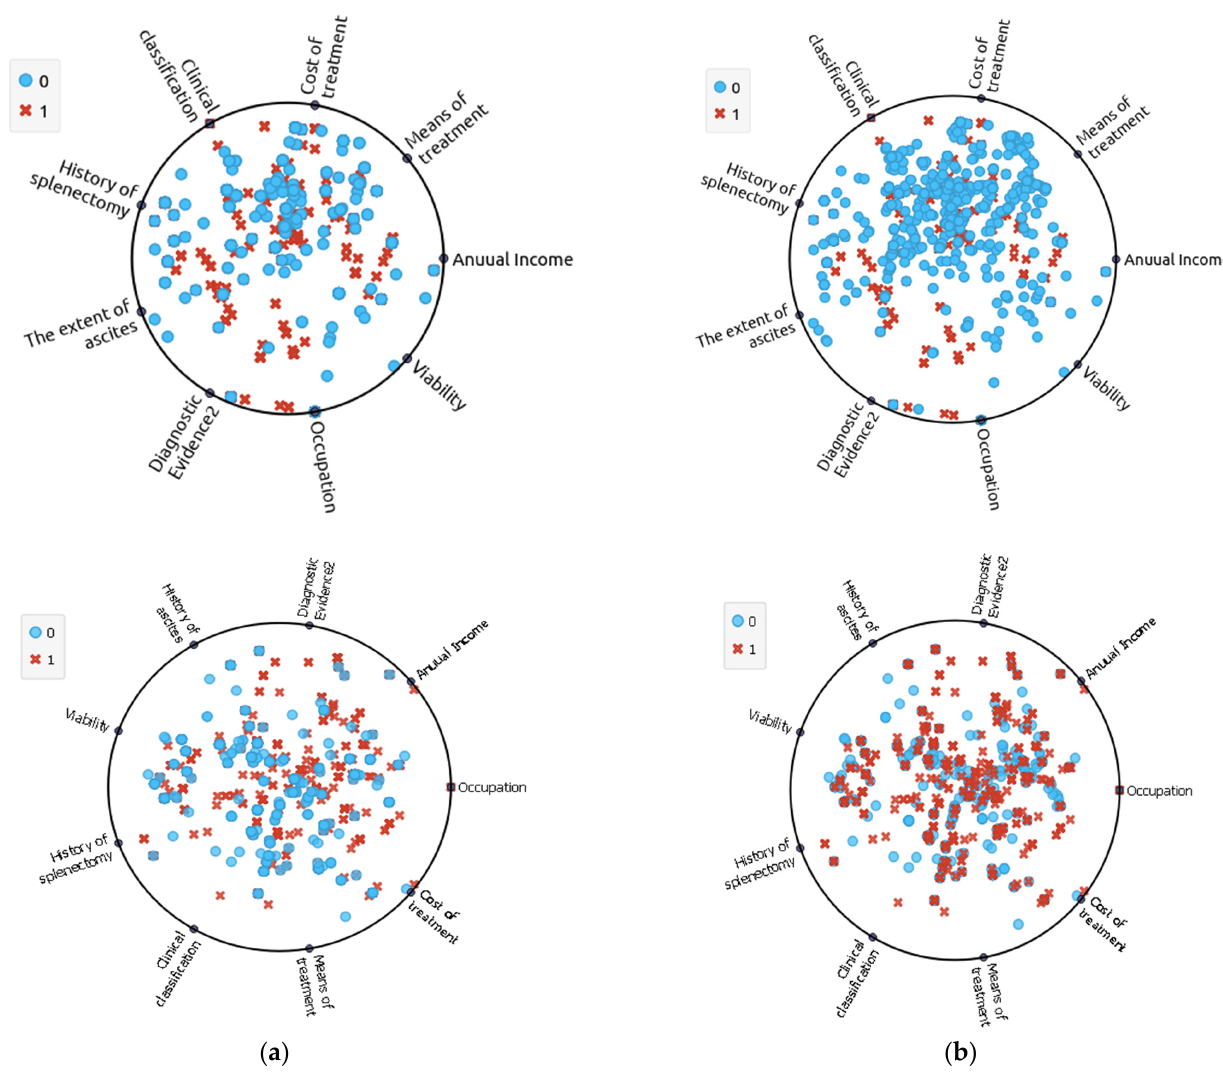
Figure 2. Visualisation of data before and after resampling: ( a ) Imbalanced dataset; ( b ) Balanced Dataset. Table 4. Dataset